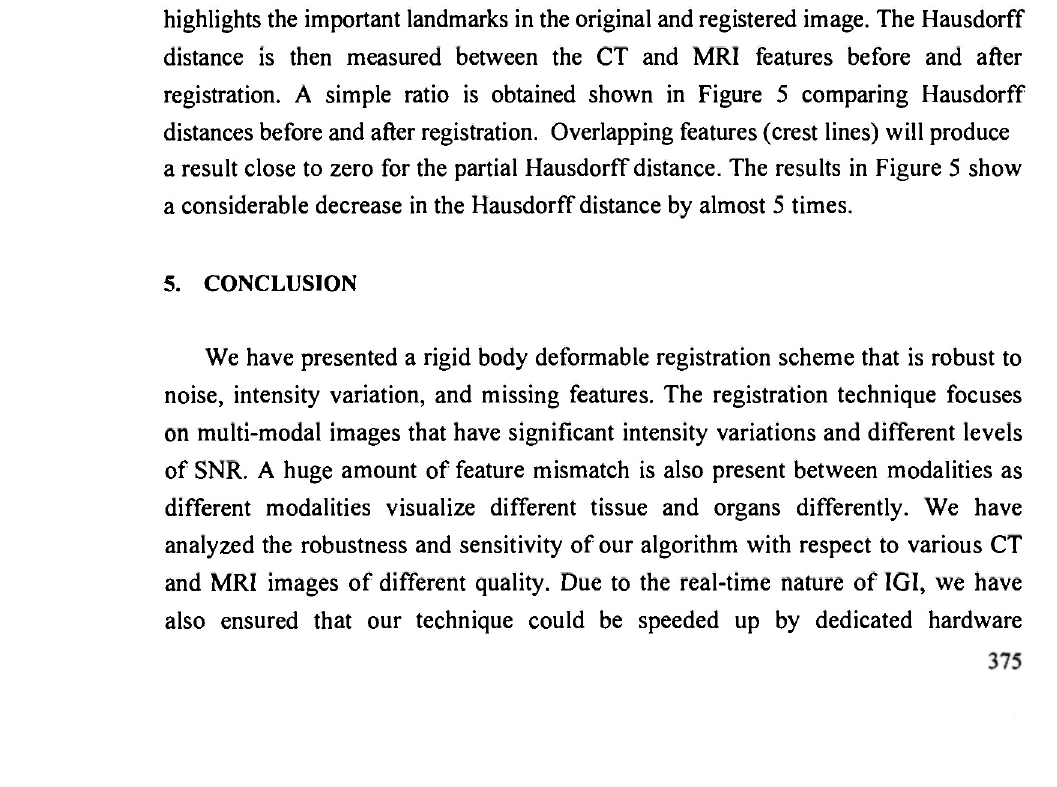
Fig. 6: The ratio of Hausdorff distances for crestlines is obtained before and after registration for the first 5 images of goldcrest database. The results show that the Hausdorff distance after registration decreases